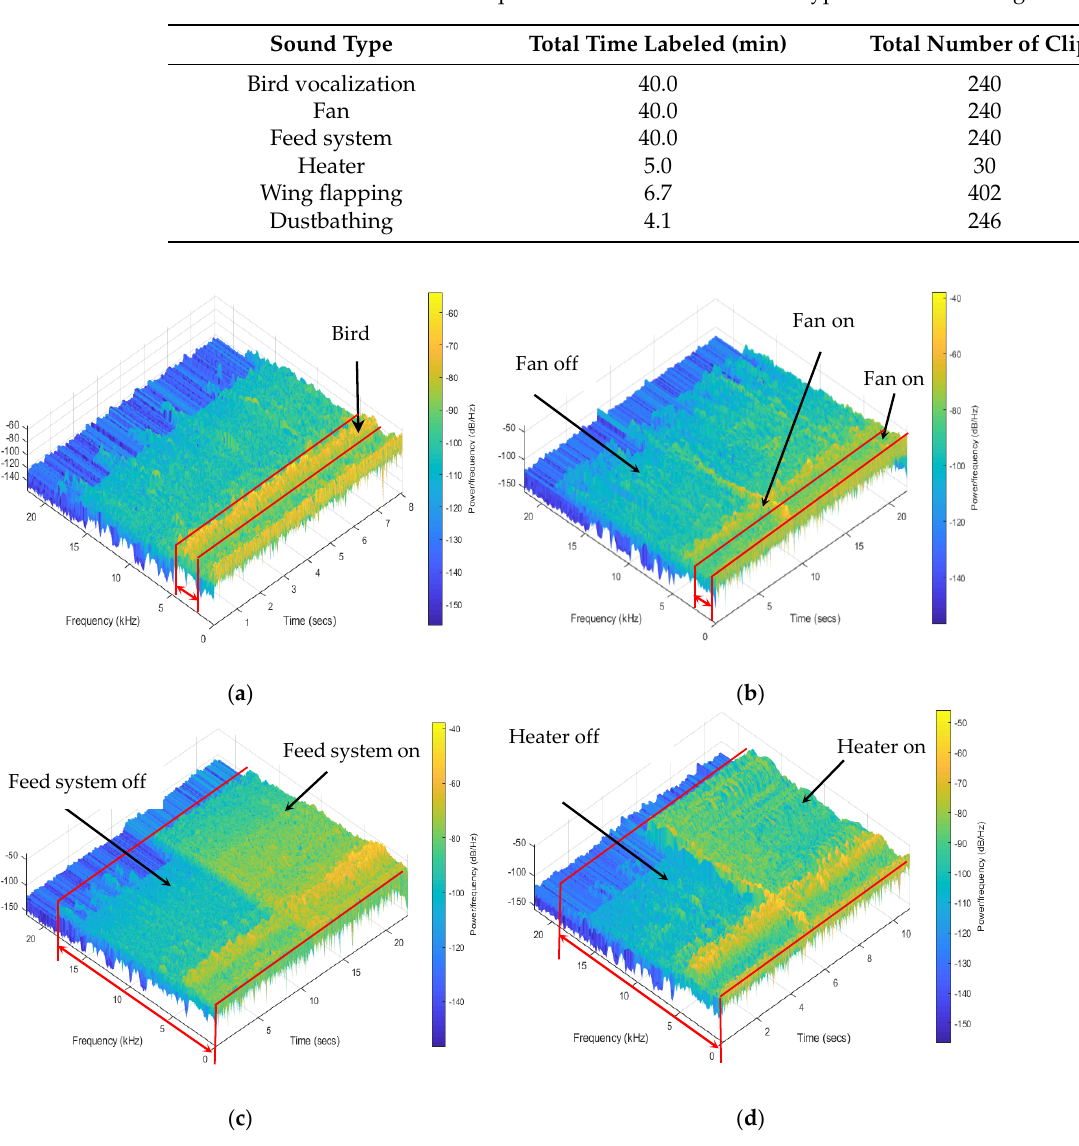
( f ) Figure 2. Example signals of bird vocalization ( a ), fan ( b ), feed system ( c ), heater ( d ), wing flapping ( e ) and dustbathing ( f ) in frequency domain. 2.5. Maximum Overlap Discrete Wavelet Transform (MODWT) The MODWT is a linear filtering operation that transforms a signal into multilevel wavelet and scaling coefficients [19]. As the flowchart for three-level MODWT shown in Figure 3, the MODWT applies low/high-pass filters to split the frequency components of the input signal into different scales. The filters are determined depending on the mother